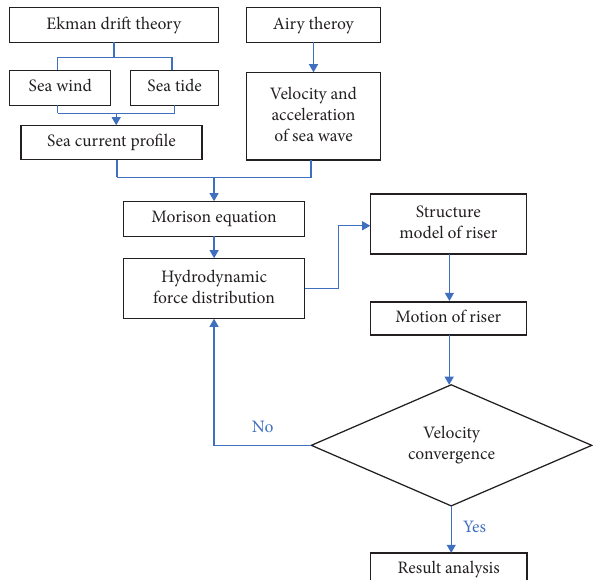
Figure 2: Flow chart for the solution procedure via an iterative